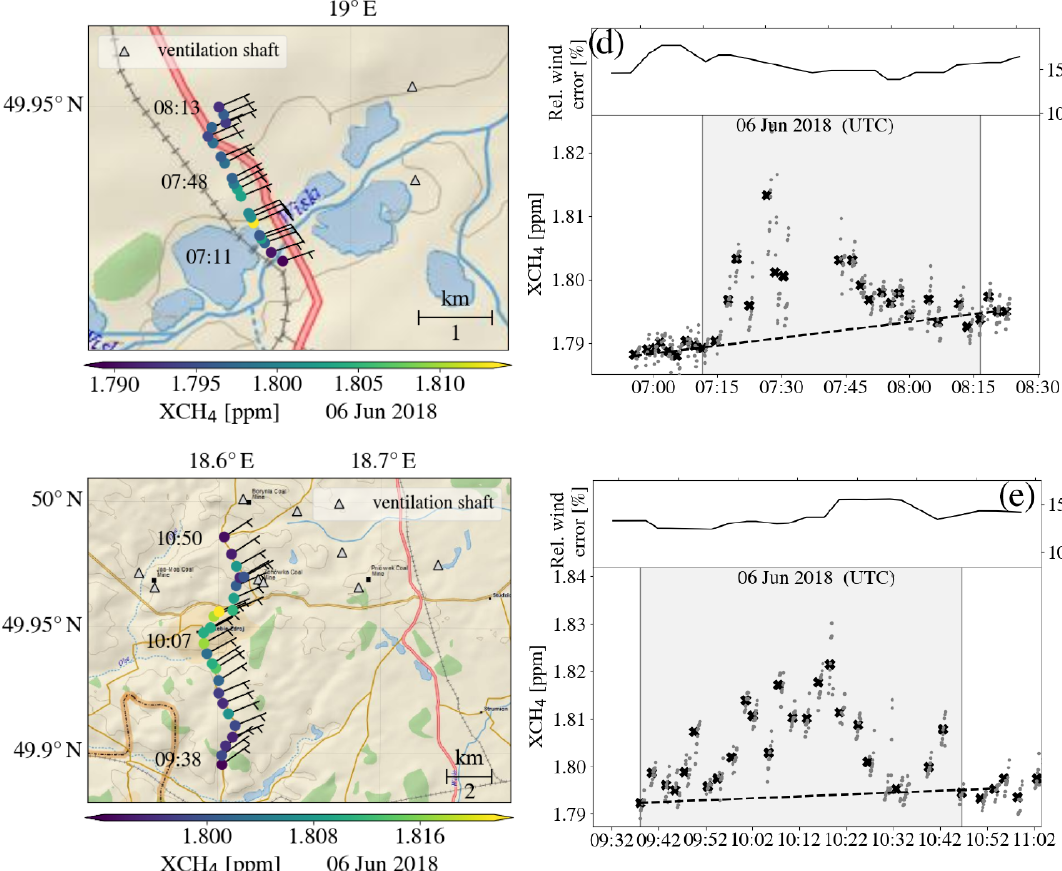
Figure 4. XCH 4 measured for five transects downwind of the coal mine ventilation in the USCB (panel rows a–e ). Left panels display the driven path and the locations of each observation. Wind barbs indicate the wind direction. Note that on 1 June wind speed was very low ( < 2 . 5ms − 1 ) and the wind barbs are not resolved. However, the general wind direction was south-east. The targeted mining ventilation shafts are marked as grey triangles. Right-hand panels display measured XCH 4 as grey dots and respective local stop-wise averages as black crosses. The best-estimate background XCH 4 is indicated as a dashed black line. Grey areas represent the measurements identified as intra- plume. The black line on top of every right-hand side panel displays the combined relative wind error for each measurement. Dashed grey lines in panel (a) illustrate all background options contributing to the background related error. Geographic maps from ESRI